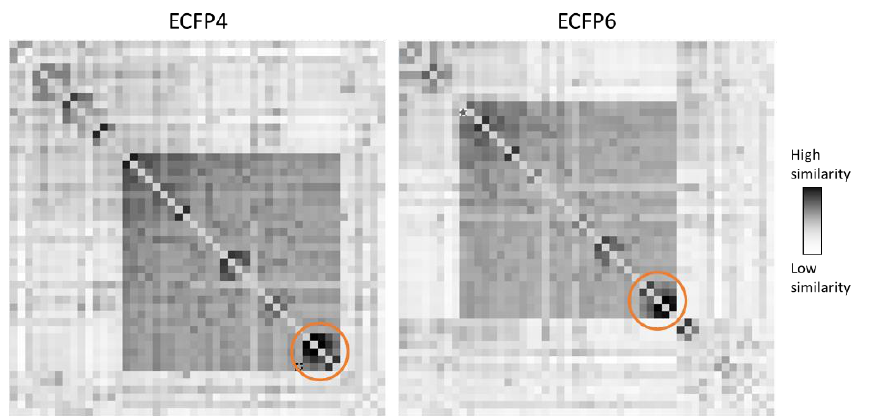
Figure 3. ECFP4 and FCFP4 fingerprint similarity matrix. Circled in orange is the highest similarity among the compounds (molecules 1 , 4d , and 8a – c ).